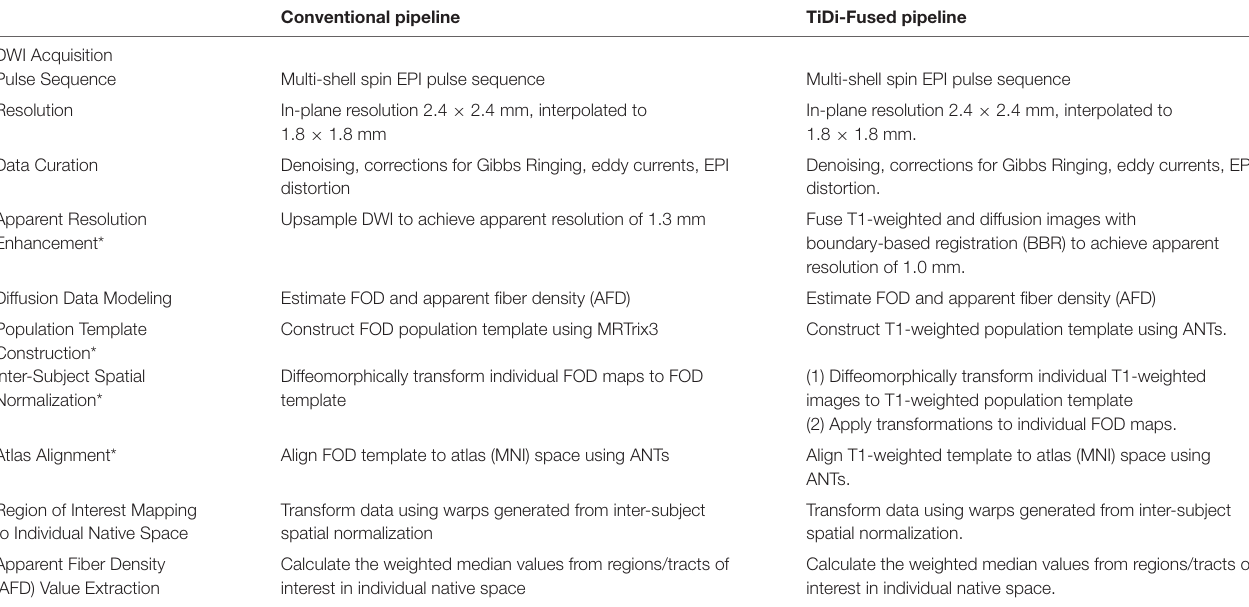
TABLE 1 | Comparison of conventional and TiDi-Fused processing pipelines. Conventional